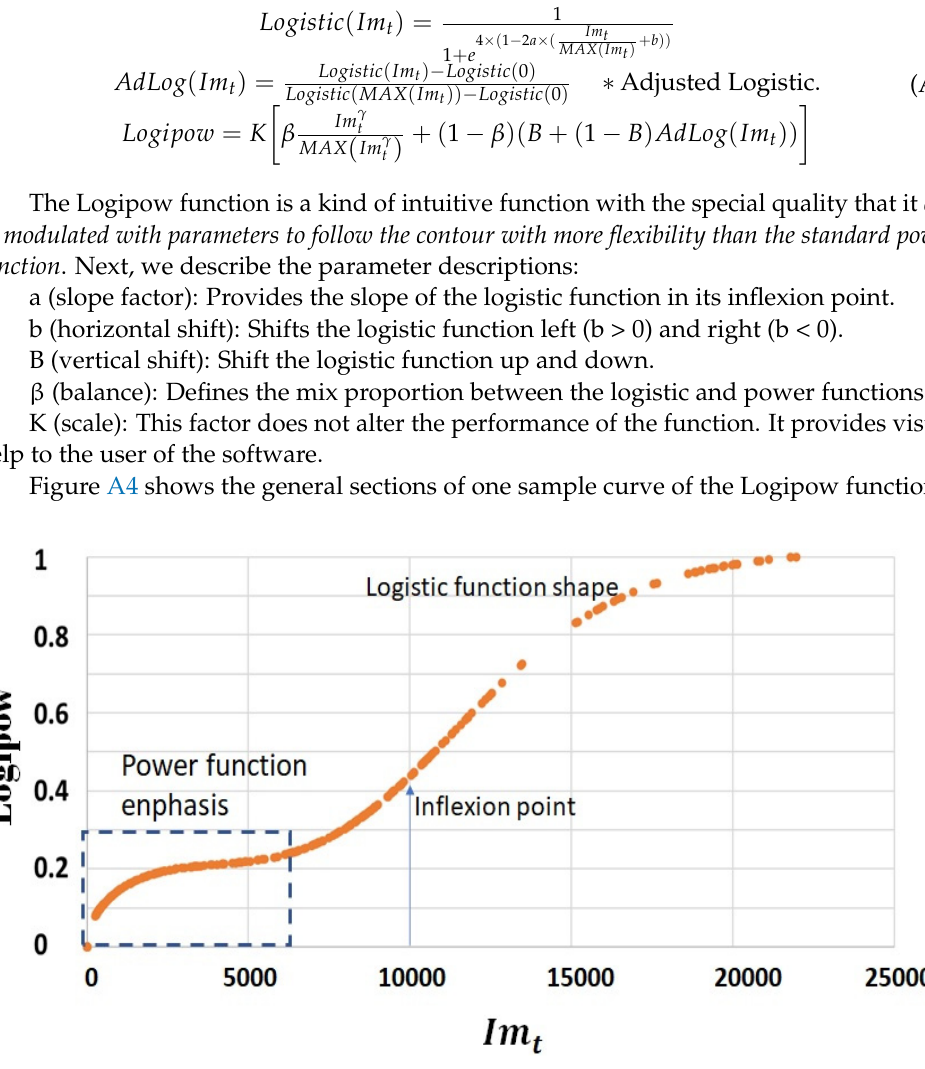
Figure A5. Superposition of 95% confidence intervals calculated with the exact probability density function and a subrogated Gamma density function.